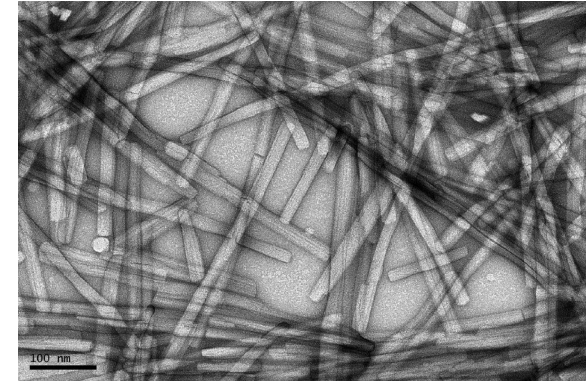
Figure 1 Electron micrograph of the adenovirus amyloid fibrils.